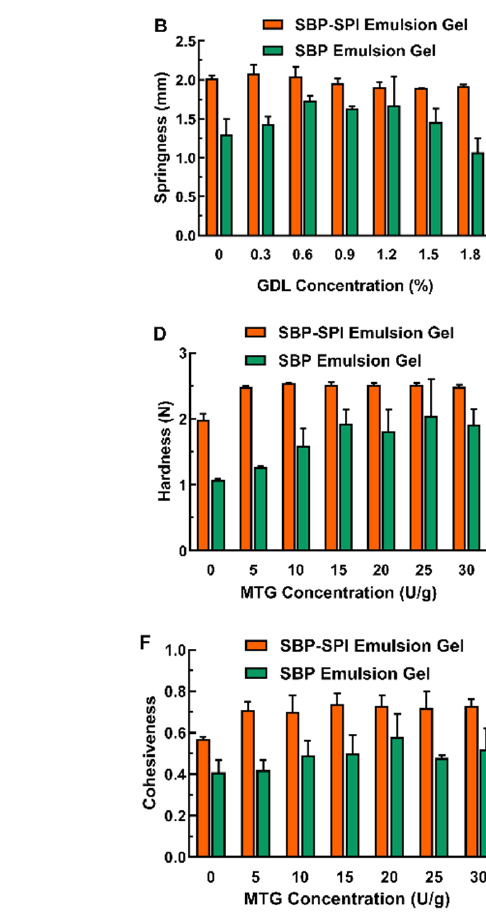
Figure 1. The hardness ( A , D ), springiness ( B , E ), and cohesiveness ( C , F ) of SPI-SBP and SBP emulsion gels induced by L&GDL ( A – C ) and L&MTG ( D – F ).